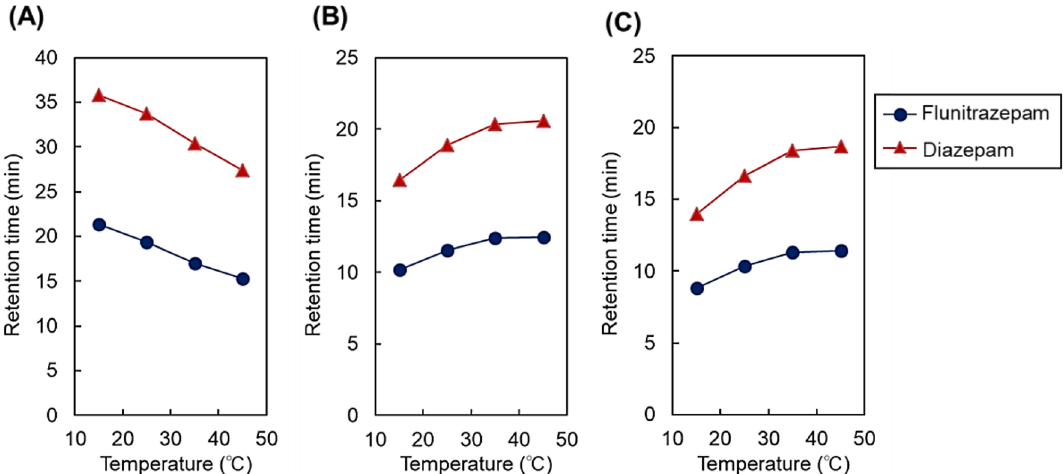
Figure 5. Retention time of benzodiazepines using P(NIPAAm- co -BMA) hydrogel-modified bead columns with ( A ) 7-nm pore-diameter beads, ( B ) 12-nm pore-diameter beads, and ( C ) 30-nm pore-diameter beads as base